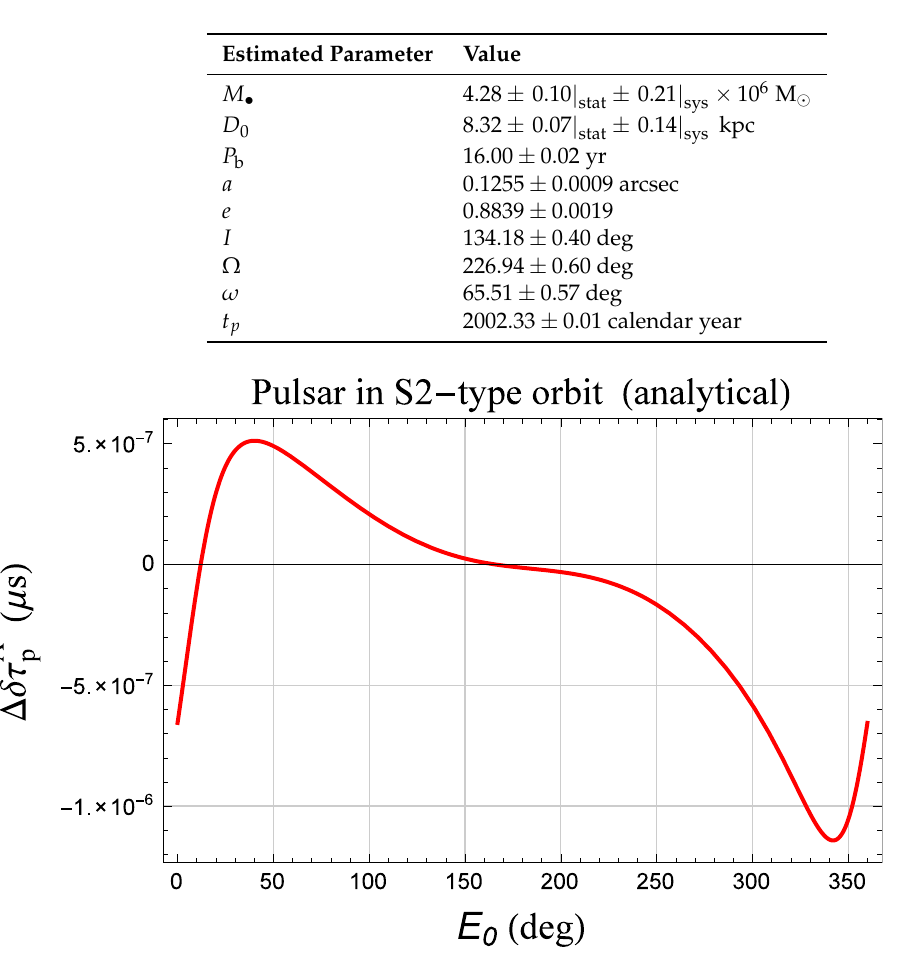
Table A1. Relevant physical and orbital parameters of the S2 star and the SMBH at the GC along with their estimated uncertainties according to Table 3 of Gillessen et al. [73]; they are referred to the epoch 2000.0. D 0 is the distance to Sgr A ∗ . The linear size of the semimajor axis of S2 is a = 1044 au.